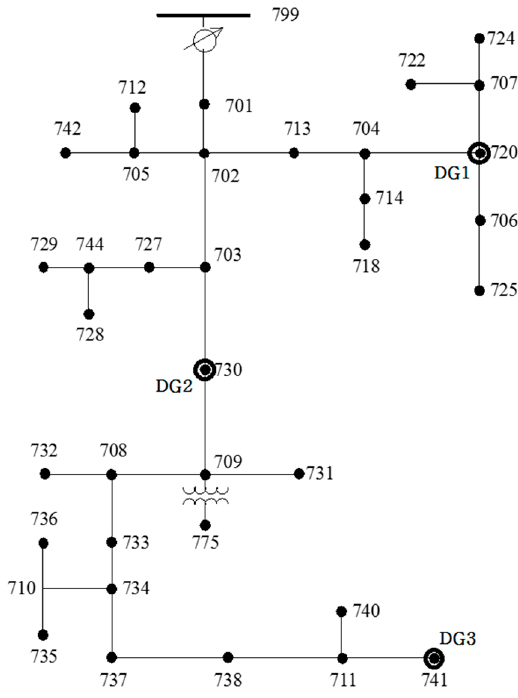
Figure 4. IEEE 37 node test feeder [29].